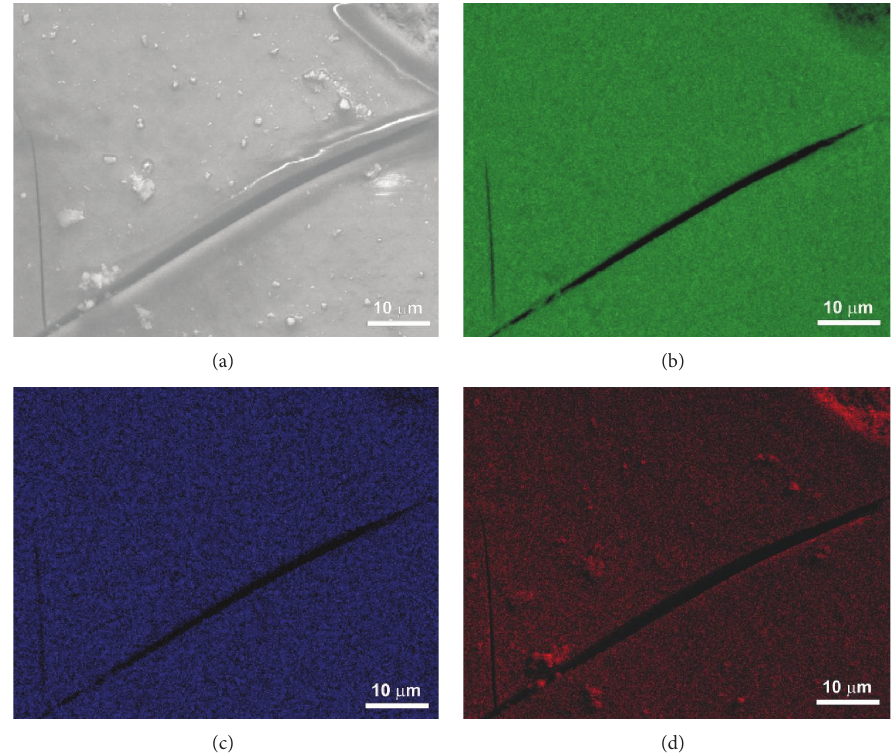
Figure 3: Results of X-ray microanalysis: (a) secondary electron image of selected area of TiO 2 :Nd (3 at. %), (b) Ti, (c) Nd, and (d) O elements concentration distribution.